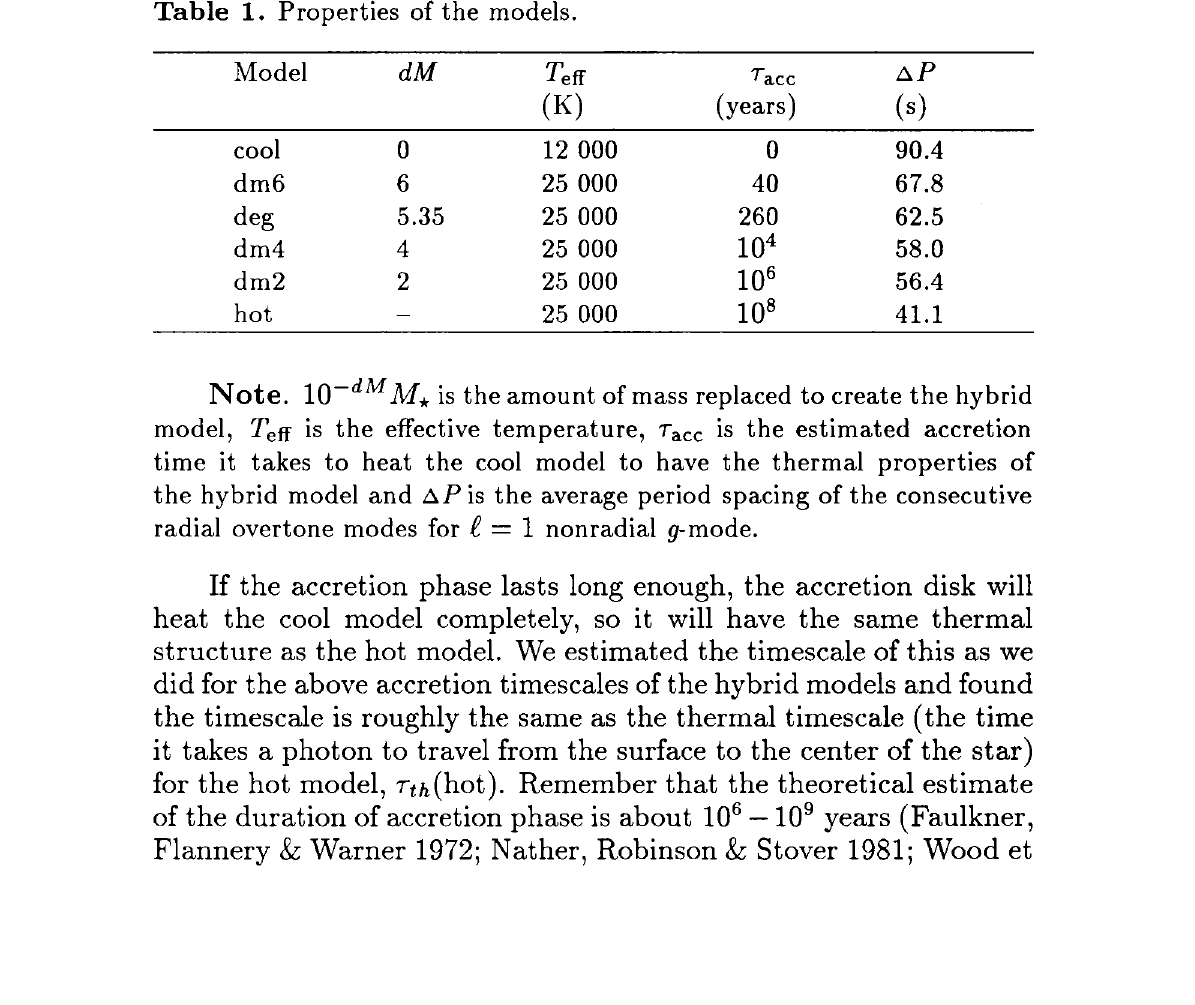
Table 1. Properties of the